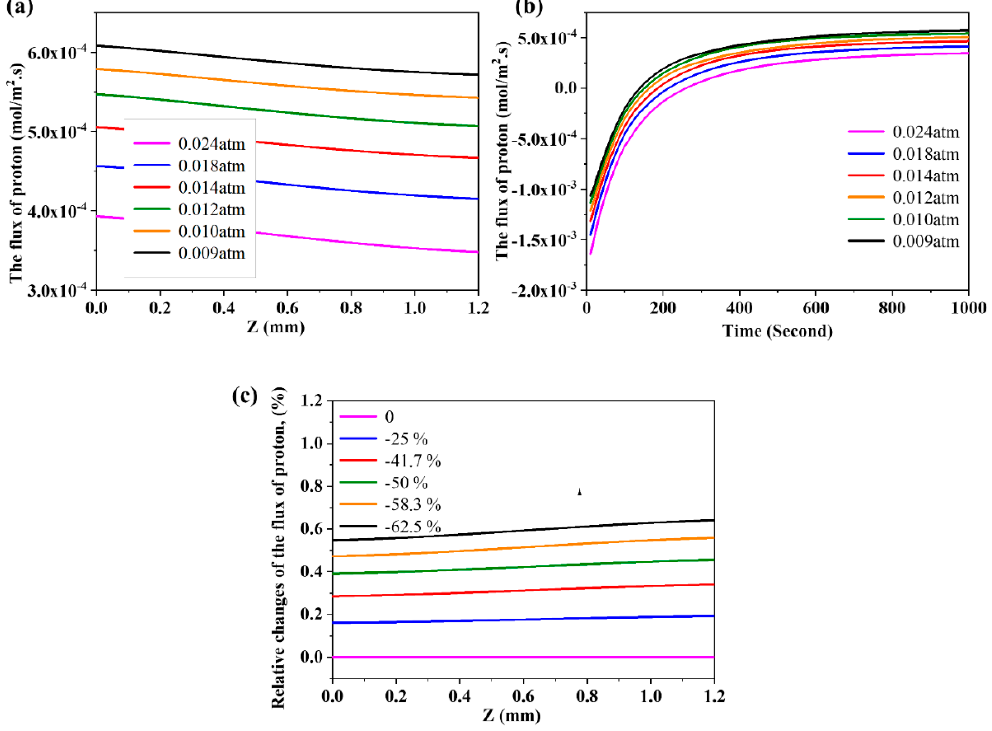
Figure 7. ( a ) The effect of partial pressure of steam on the flux of proton; ( b ) the effect of partial pressure of steam on the evolution of flux of proton; and ( c ) normalized analysis of the effect from partial pressure of steam on the flux of proton.